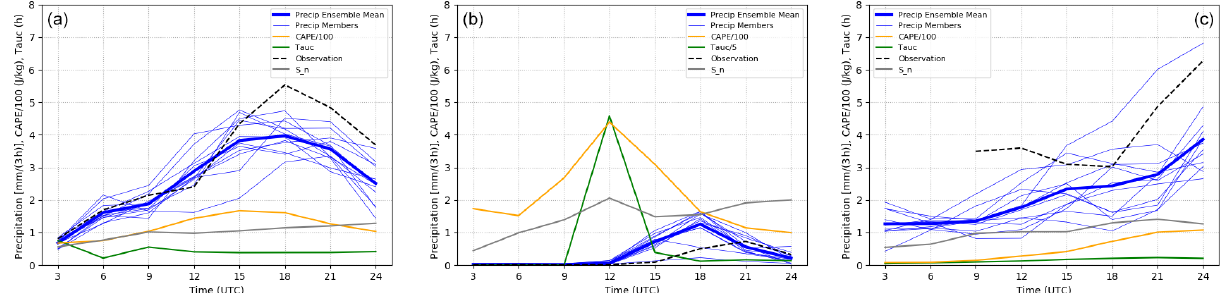
Figure 6. Time series of ensemble mean area-averaged precipitation, its normalized standard deviation S n , ensemble mean CAPE and the convective adjustment timescale τ c for the prominent cases (a) HyMeX IOP16a, (b) HyMeX 11 September 2012 and (c) NAWDEX 13 October 2016. Precipitation time series of the individual ensemble members highlights intra-ensemble variability. Additionally area- averaged rain-gauge observations are shown. Note the different scaling of τ c on 11 September